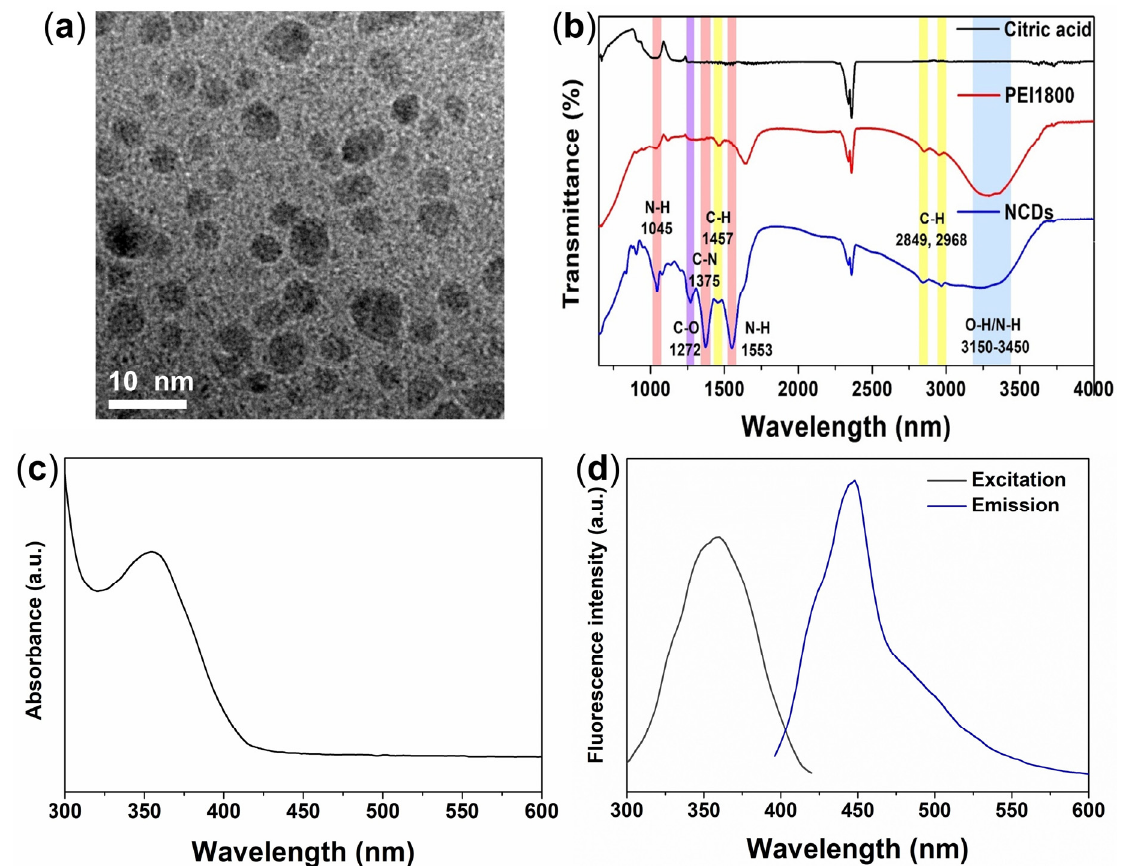
Figure 2. ( a ) TEM image of NCDs. ( b ) FTIR spectra of citric acid, PEI1800 and NCDs for confirmation of surface groups on NCDs. ( c ) UV–Vis absorption spectrum of NCDs. ( d ) The optimal fluorescence spectra of